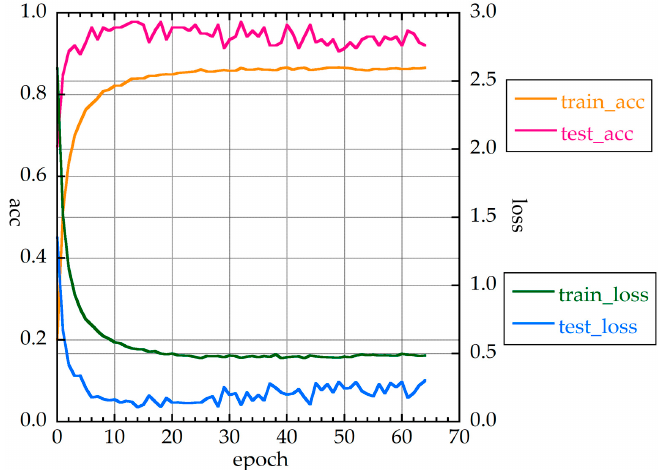
Figure 8. Accuracies and loss function values of CNN2d for 30 measurements. Table 4. The layer structure of CNN2d for 30 measurements.